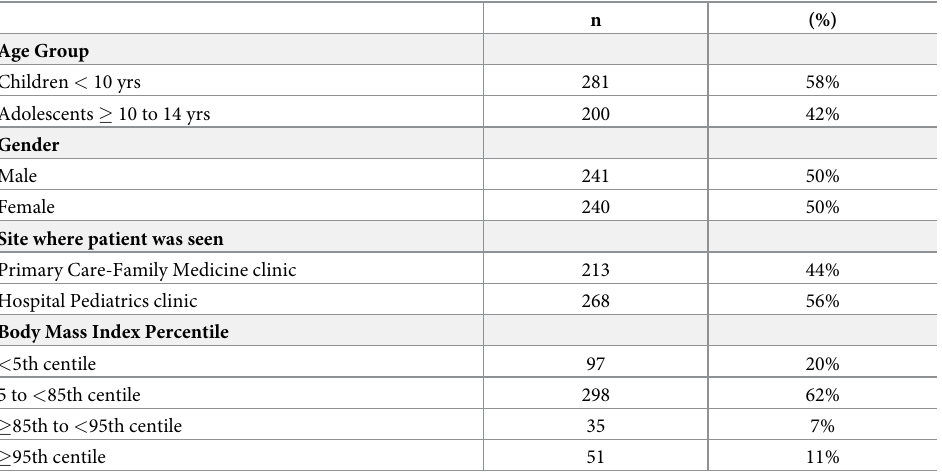
Table 1. Characteristics of the study subjects (N =